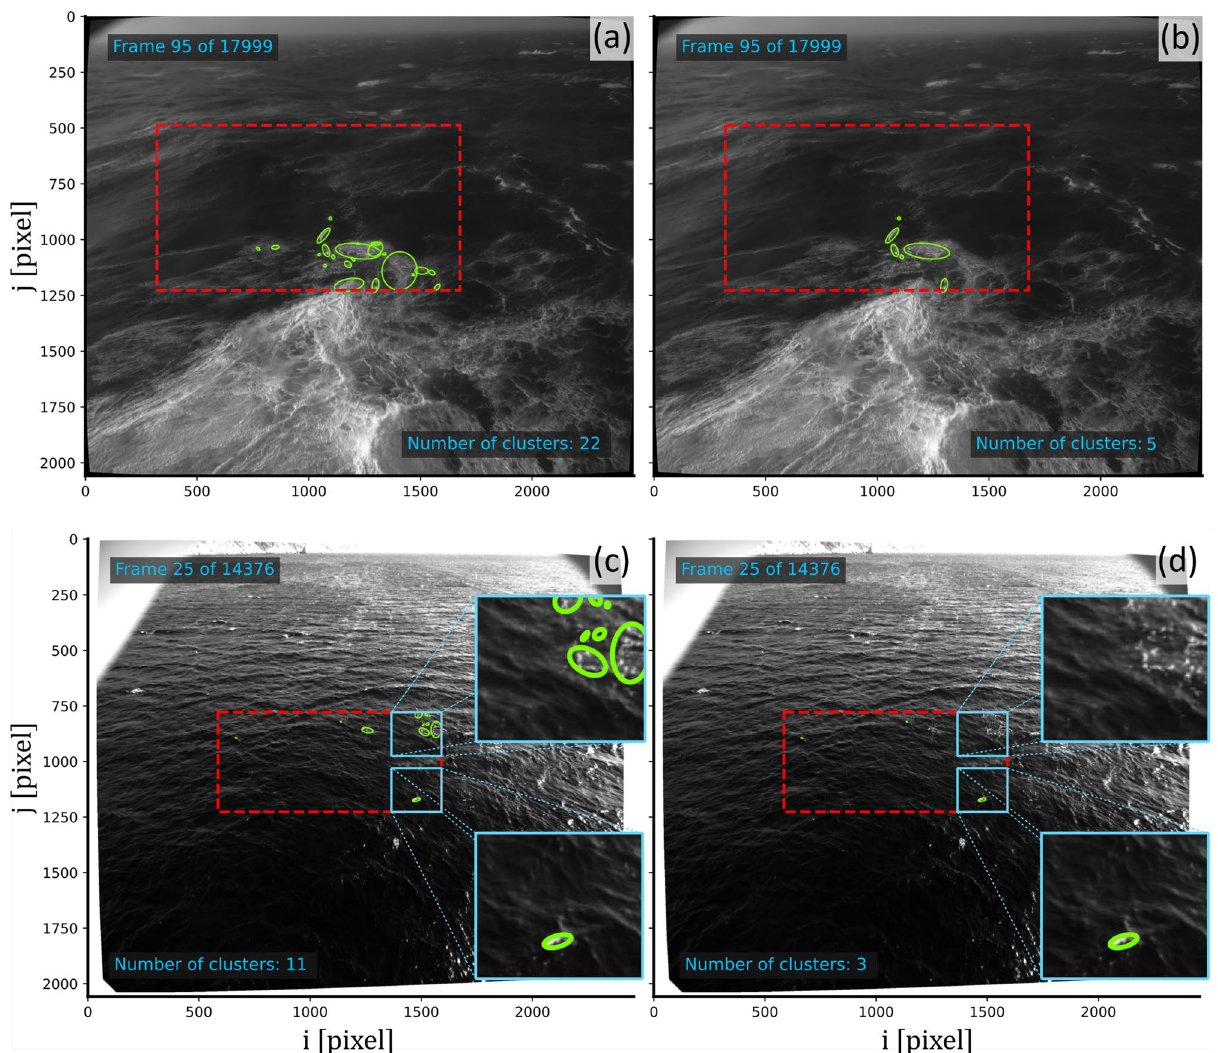
detected as active wave breaking. ( b ) Results of active wave breaking detection using VGG16 as backbone for La Jument data (03/01/2018 09:39). Note the significant reduction in the amount of passive foam being detected. In both plots, number of clusters refers to the number of clusters identified by DBSCAN. The red dashed rectangle indicates the region of interest which, in these examples, was the same as the stereo-video reconstruction area. ( c ) Results of the naïve wave breaking detection (thresholding + DBSCAN) for Black sea data (04/10/2011 09:38). ( d ) Results of active wave breaking detection using VGG16 as backbone for Black Sea data (04/10/2011 09:38). Animations of these results are available at https ://githu b.com/caios tring ari/deepw aves. In this particular example, the image was subdivided into blocks of 256 × 256 pixels for processing. Note that identical results were seen using other architectures other than VGG16 to classify these